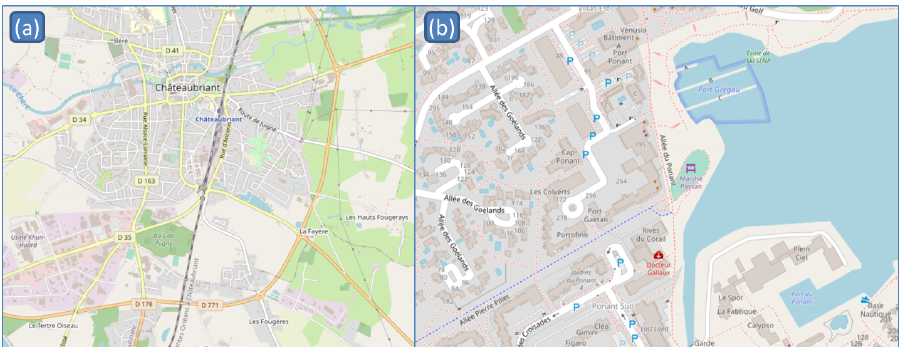
Figure 11. Two examples where a failed anticipation might occur. ( a ) The Gestalt principle of closure anticipates a ring road around the town of Chateaubriant, France, whereas it only covers three fourth of the extent. ( b ) The water surface in the coastal town of La Grande Motte, France seems to be the Mediterranean Sea, but it is a lake, and the sea shore is just south of this place (©OpenStreetMap contributors).